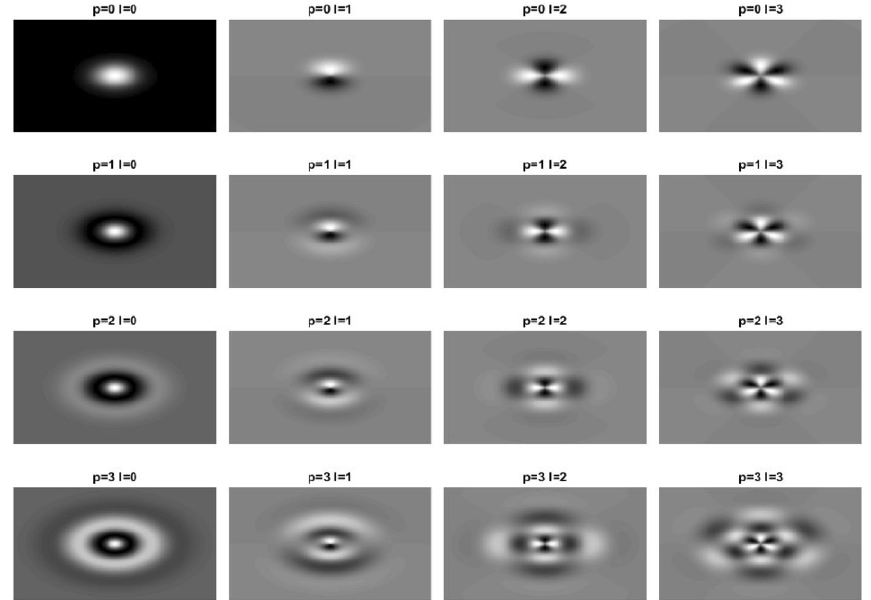
Figure 3. Example of the Laguerre–Gaussian